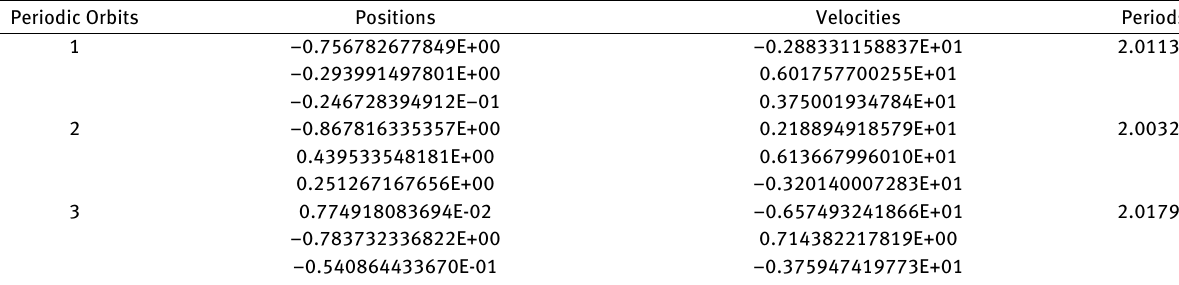
Table 4. The initial positions and velocities of periodic orbits in the body-fixed frame of Kalliope Periodic Orbits Positions Velocities Periods